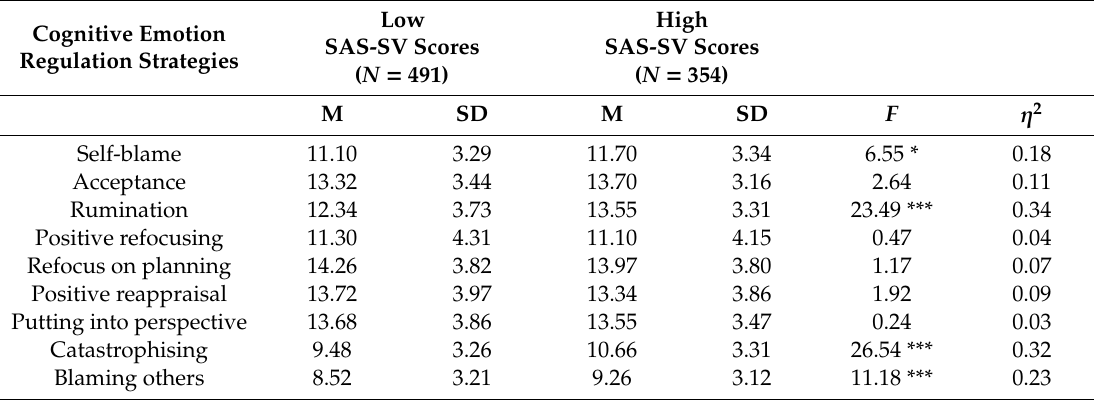
Table 2. Di ff erences in Cognitive Emotion Regulation strategies between high and low Smartphone Addiction (SAS-SV) scores.